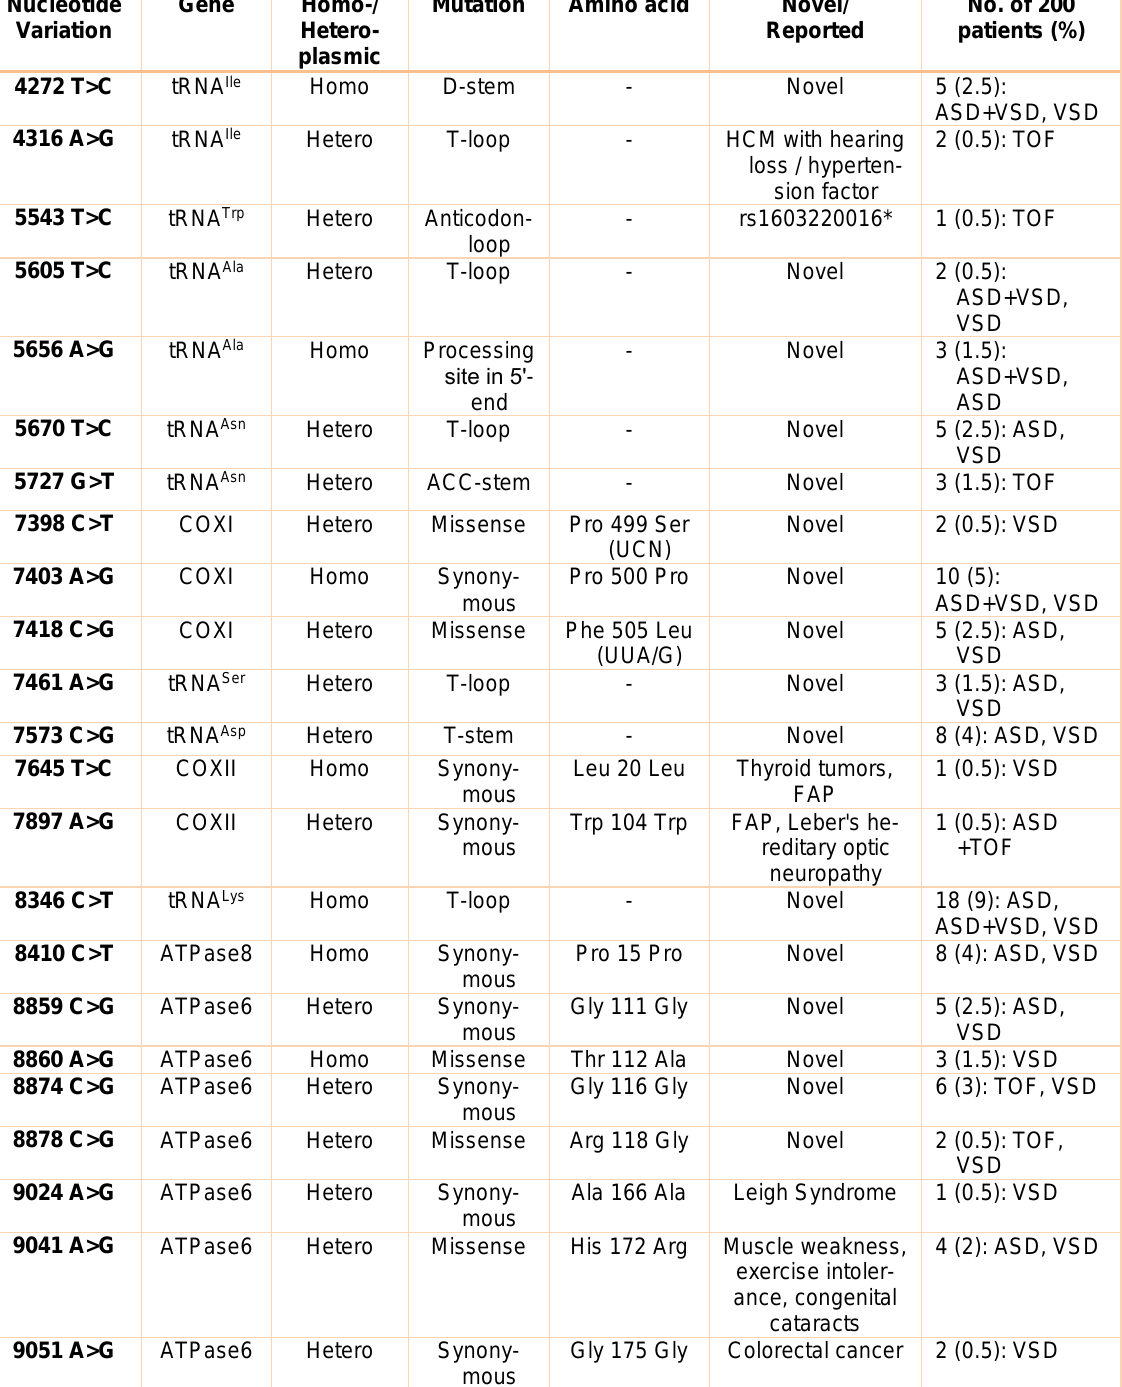
Table 3: Nucleotide variations in mtDNA observed in the selected coding regions and tRNA